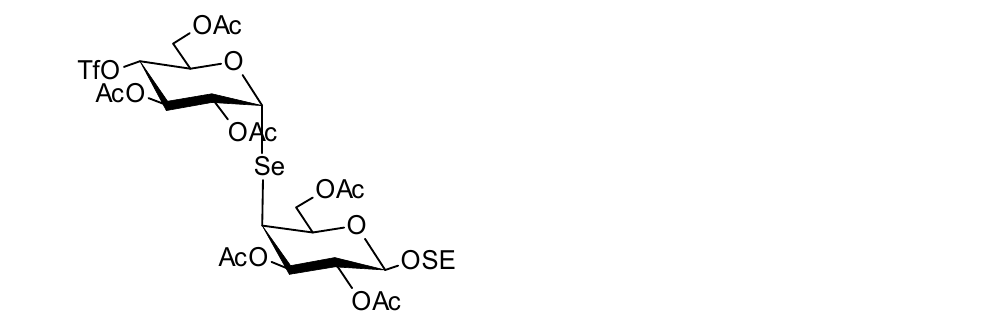
Figure 4. An example of a structure of the protected selenodisaccharide (Gal p α (1 → 4)Gal p ) synthe- sized by Nanami et al. [239]. SE-2-(trimethylsilyl)ethyl-group, Tf-trifluoromethanesulfonyl-(triflyl-) group.